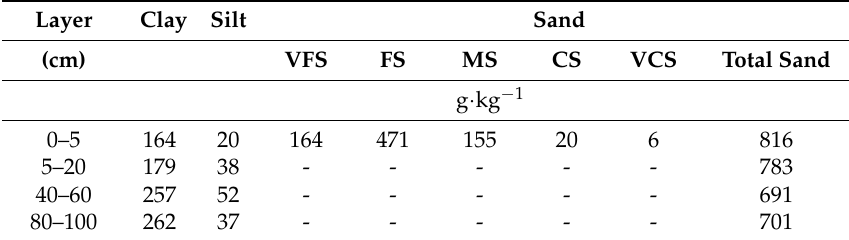
Table 1. Particle size distribution for the soil